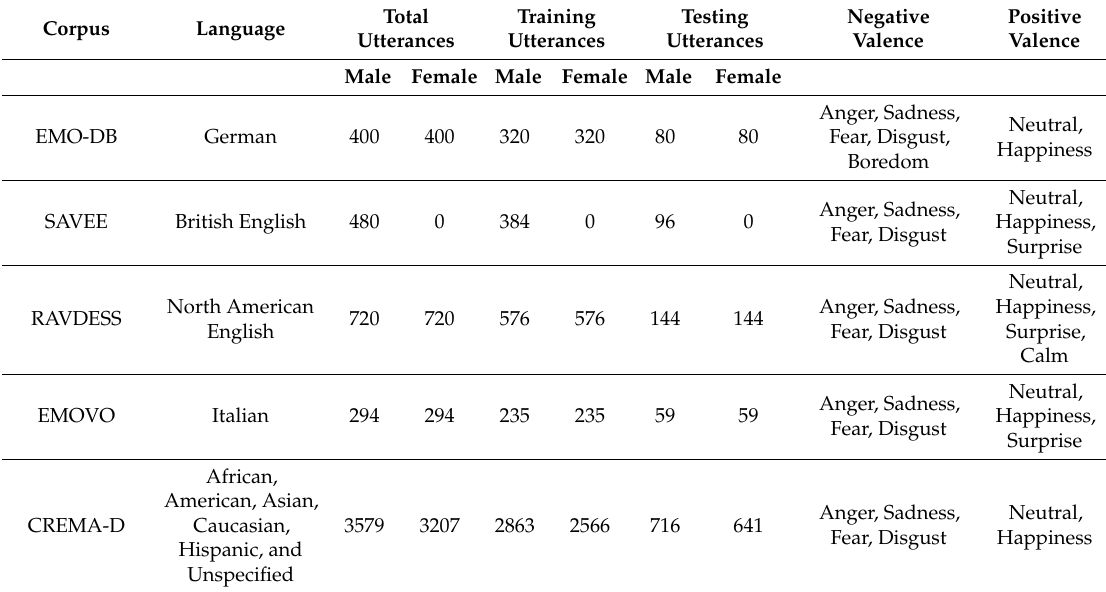
Table 2. Mappings of adult speech emotions into positive and negative valence